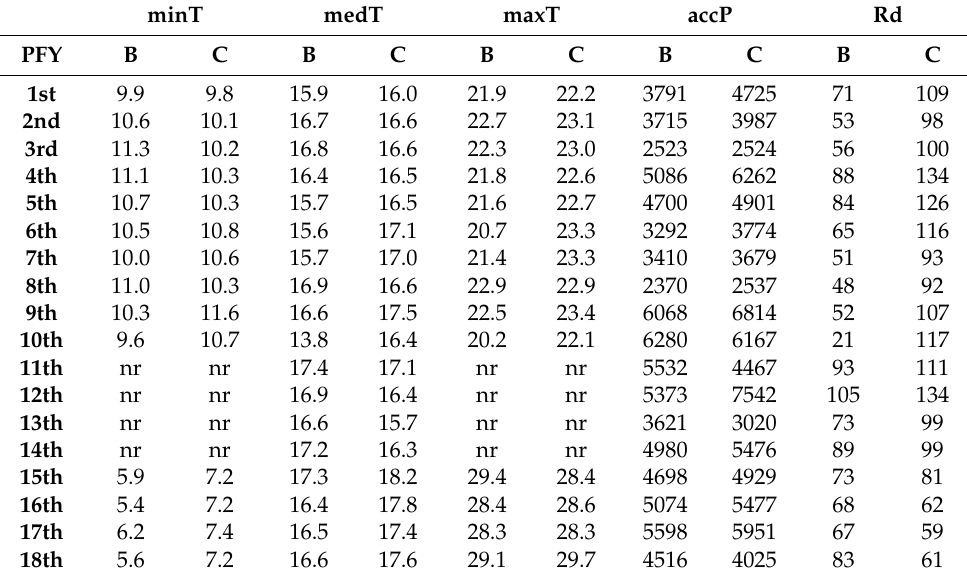
Data of climate variables were obtained from six weather stations of AEMET (Spanish Meteorological Agency) located in the burned and in the control areas. Annual data, average or accumulated values, related to temperature and precipitation, respectively, were obtained from monthly data of the three stations located in each study area (Table 3). Table 3. Annual average of climate variables included in the study: temperature in ◦ C, minimum (minT), medium (medT) and maximum (maxT); accumulated precipitation (accP) in tenths of mm; and rainy days (Rd); by post-fire year (PFY) in the burned (B) and the control (C) areas; data not recorded by the climate stations considered